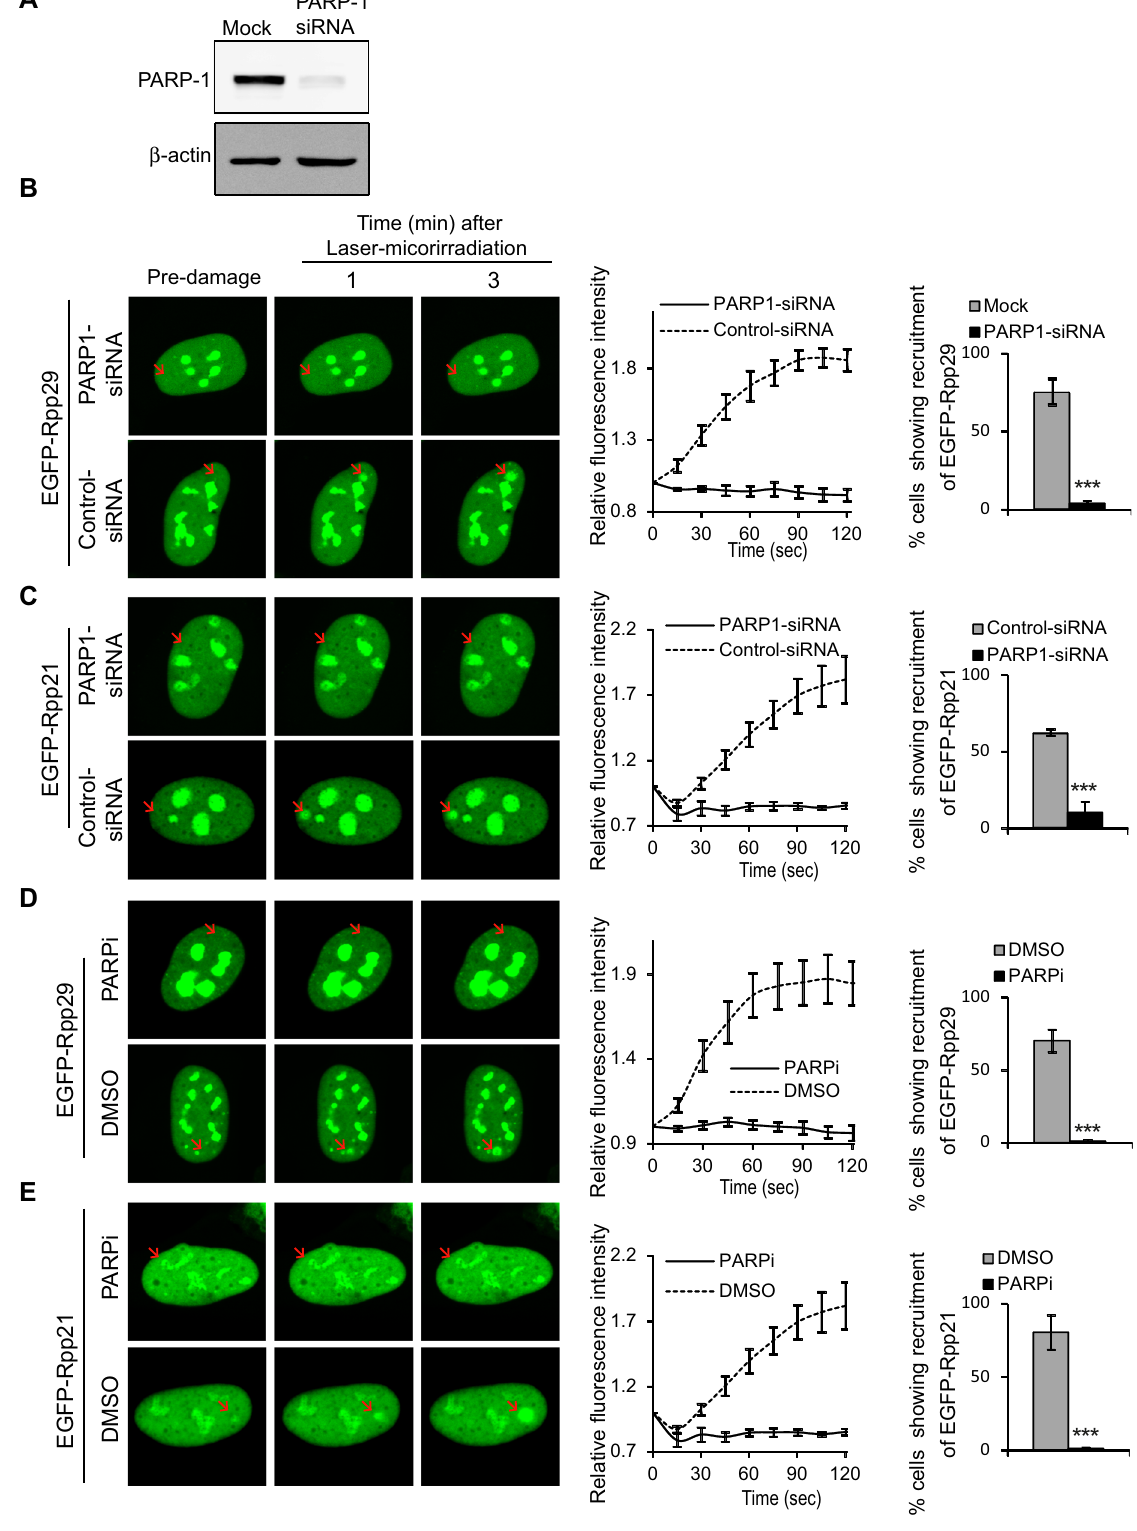
Figure 5. Rpp29 and Rpp21 are recruited to DNA damage sites in a PARP1-dependent manner. ( A ) Western blot analysis shows the efficiency of siRNA knockdown of PARP1. Protein extracts were prepared from mock and PARP1 siRNA-transfected U2OS cells and immunoblotted with PARP1 antibody. β -actin is used as a loading internal control. ( B , C ) Representative time-lapse images show subcellular distributions of EGFP-Rpp29 and EGFP-Rpp21 after laser microirradiation of mock and PARP1-depleted cells (Left). Line graphs (middle) depict fold increase in the relative fluorescence intensity of Rpp29 and Rpp21 at laser-microirradiated sites